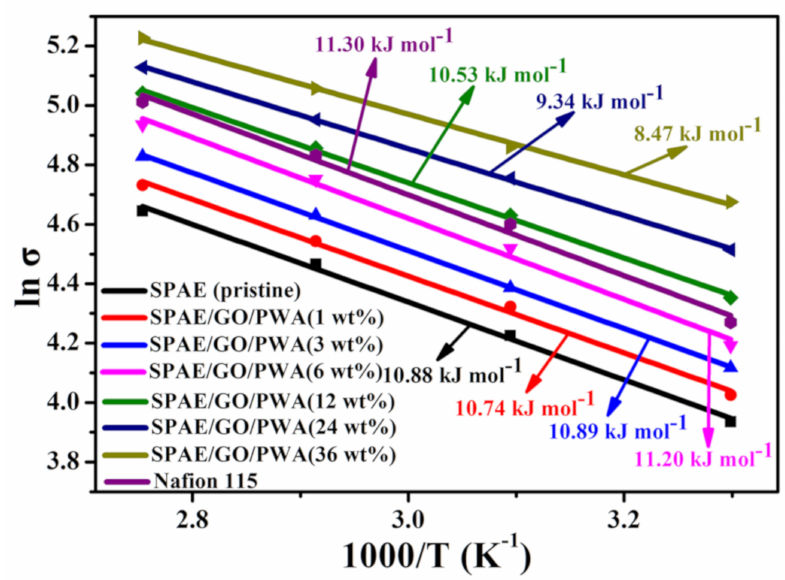
Figure 11. Arrhenius plots of SPAE composite